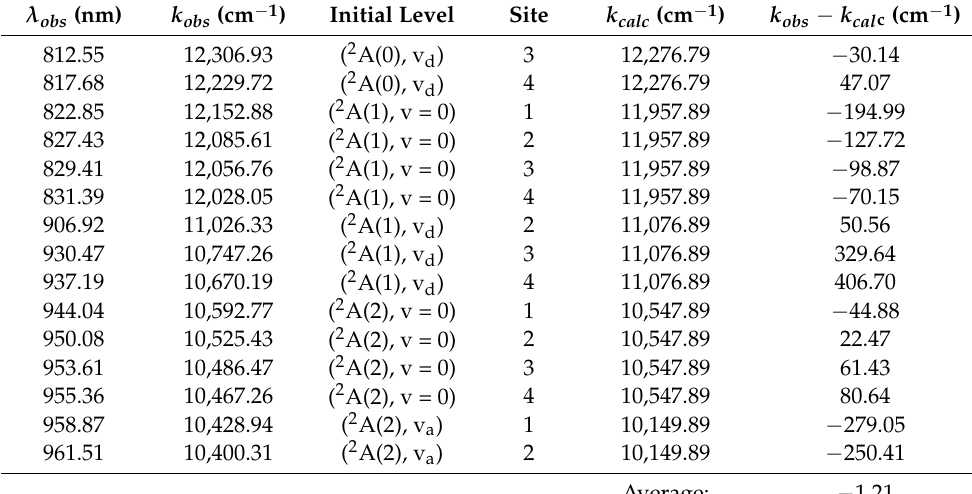
Table 2. Assignments of cooling resonances in Ti:Al 2 O 3 for π -polarization (mean fluorescence wavelength 760 nm). Wavenumbers for observed and calculated resonances are subtracted for comparison in the last column on the right. The average discrepancy is given in the bottom row.